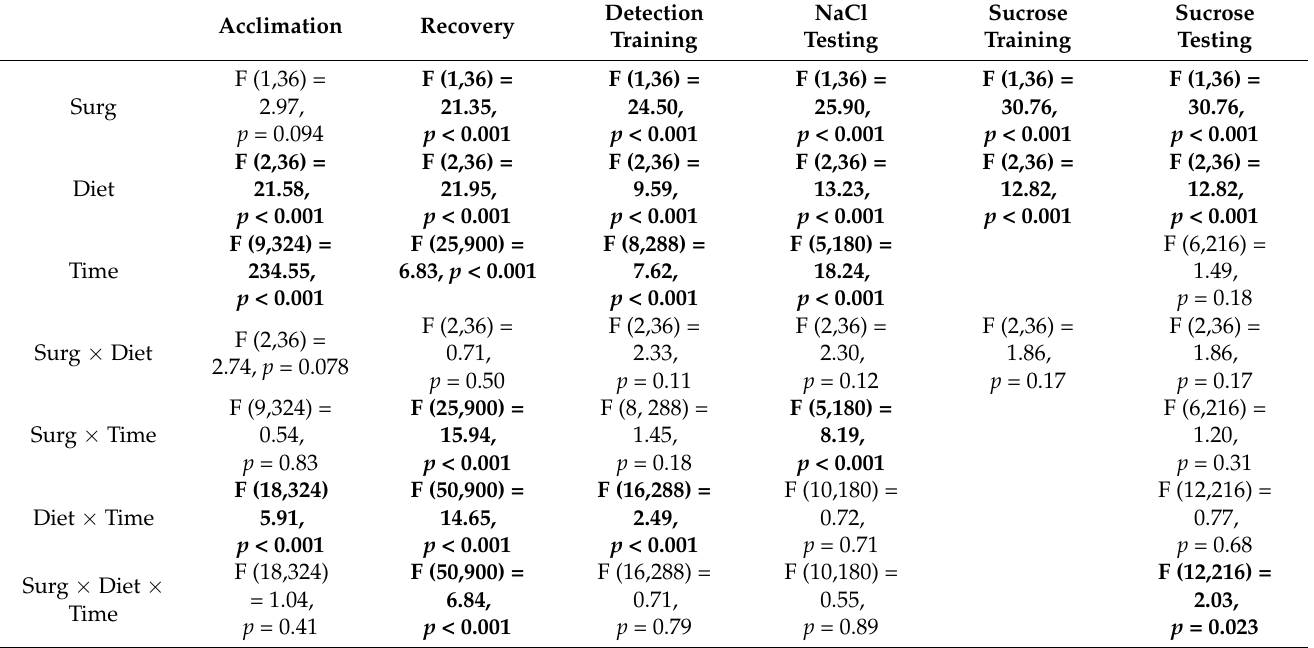
Table 3. Statistical analysis from 3-way, repeated measures ANOVA comparing body weight during critical testing periods (Figure 3 top). Significant values are noted by bold text.